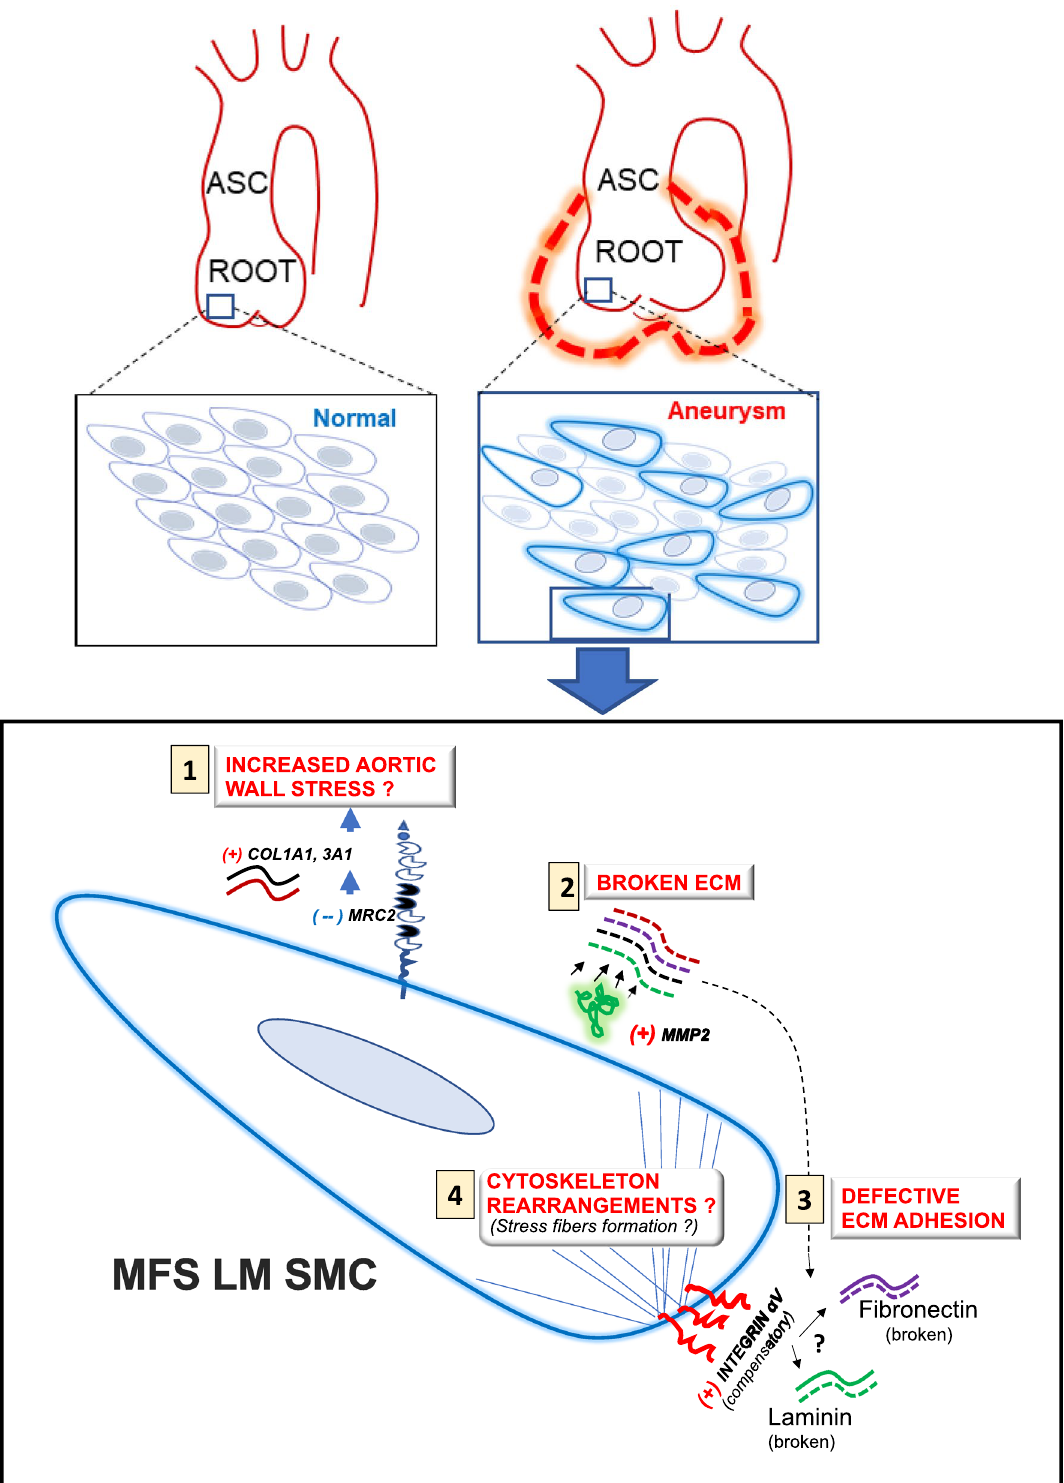
Figure 7. Proposed SMC lineage specific events during MFS aortic root aneurysm formation. ( 1 ) Reduced SMC mannose receptor 2 (MRC2) expression leads to decreased collagen internalization/breakdown, accounting for increased aortic collagen and wall stiffness. ( 2 ) Augmented matrix metalloproteinase-2 (MMP2) activity levels break down the extracellular matrix (ECM), which also may play a role in ( 3 ) defective ECM adhesion. Decreased SMC binding to the ECM, including laminin and fibronectin, causes a hypothetical reflexive increase in cell surface integrin αV expression. ( 4 ) LM SMCs in the aortic root have alterations within the